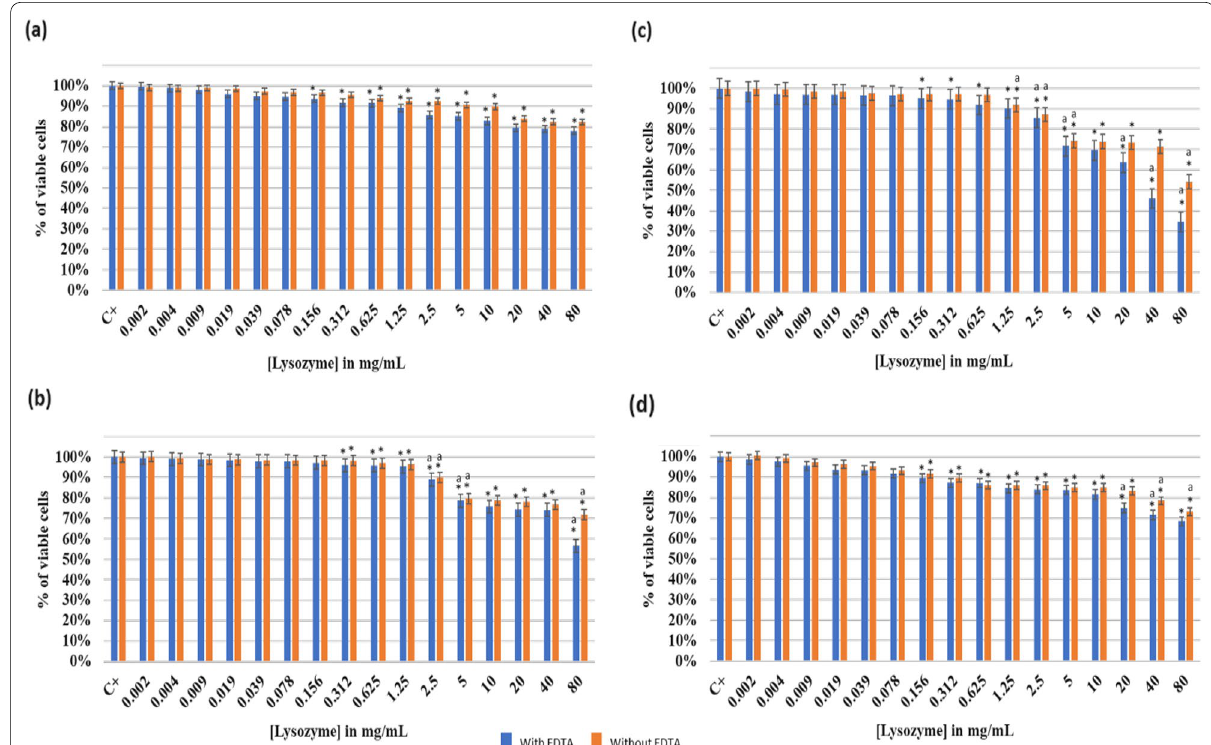
Fig. 1 Effect of lysozyme with and without EDTA (1 mM) on Lactobacillus rhamnosus GG at different pH: a pH 2; b pH 6; c pH 7.5 and d pH 8.5. The results are mean values of three replicates. OD 600 of the positive controls: C + (a) a significant difference (P < 0.05) between each test and the positive control (without lysozyme). The lowercase letter a indicates a significant difference (P < 0.05) between each test and its preceding. Error bars represent the SD (standard